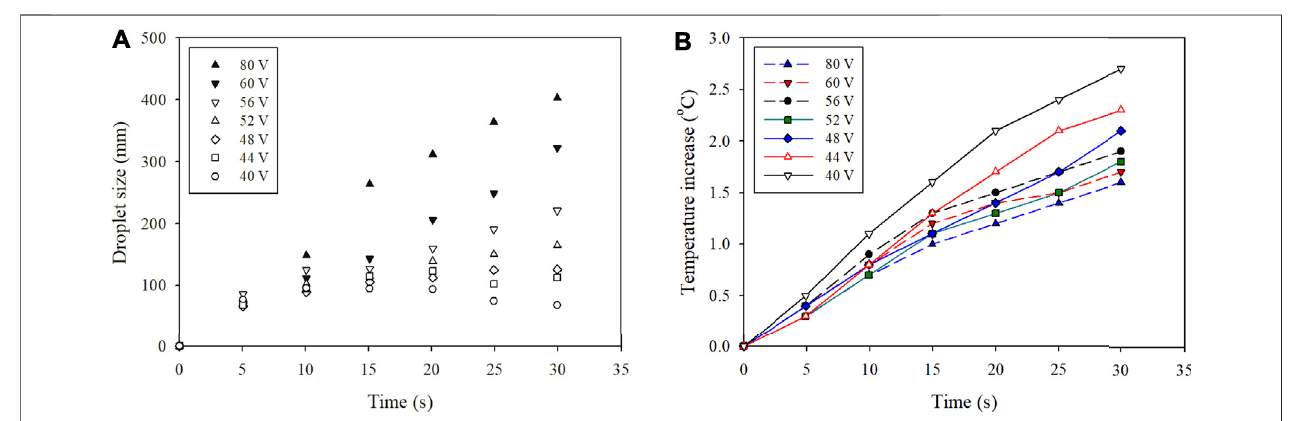
FIGURE6|(A) Thesizesofthedropletsweremeasuredovertime.Thevoltagethatpoweredtheatomizervariedfrom40to80 V. (B) Thetemperatureoftheheater was also measured throughout the test.